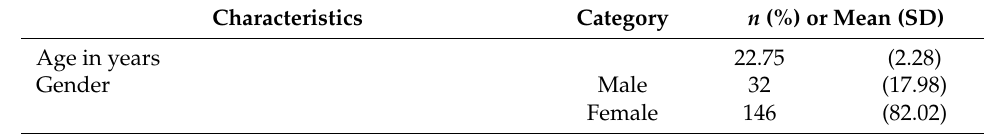
Table 1. Background characteristics of participants ( n = 178).